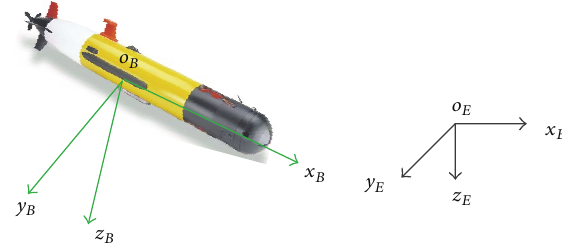
Figure 1: Coordinate systems of underactuated